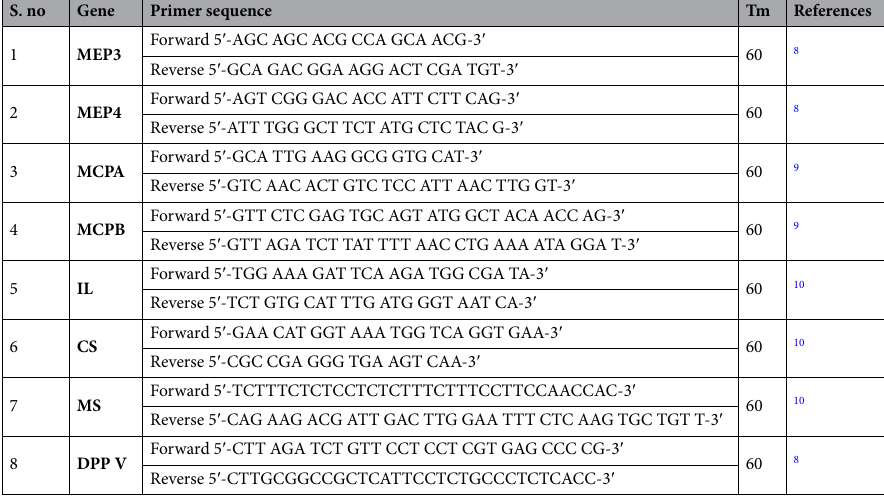
Table 4. Details of virulence genes and their specific primers of T. mentagrophytes.